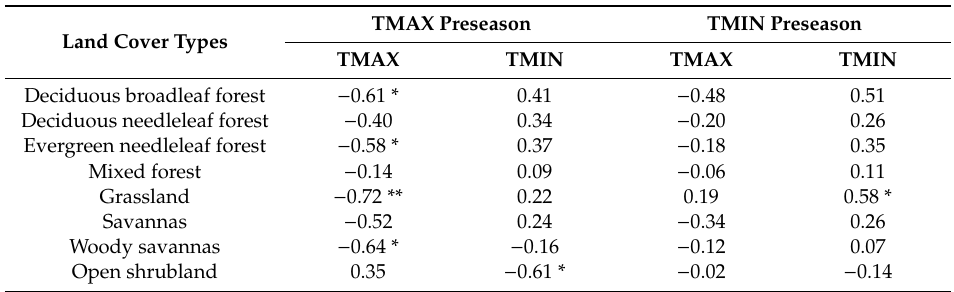
Table 2. Partial preseason correlation between spring phenology and diurnal temperature in di ff erent boreal forest land cover